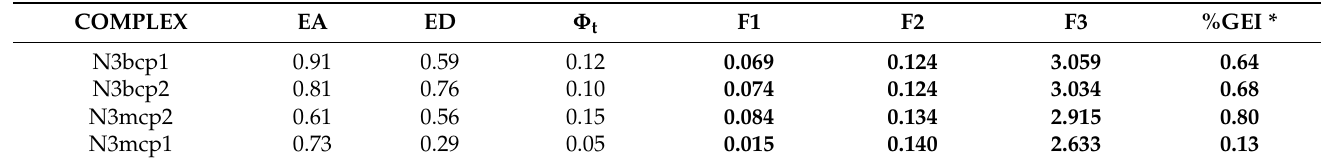
Table 9. Calculated values for the Global Efficiency Index, F1, F2, and F3.